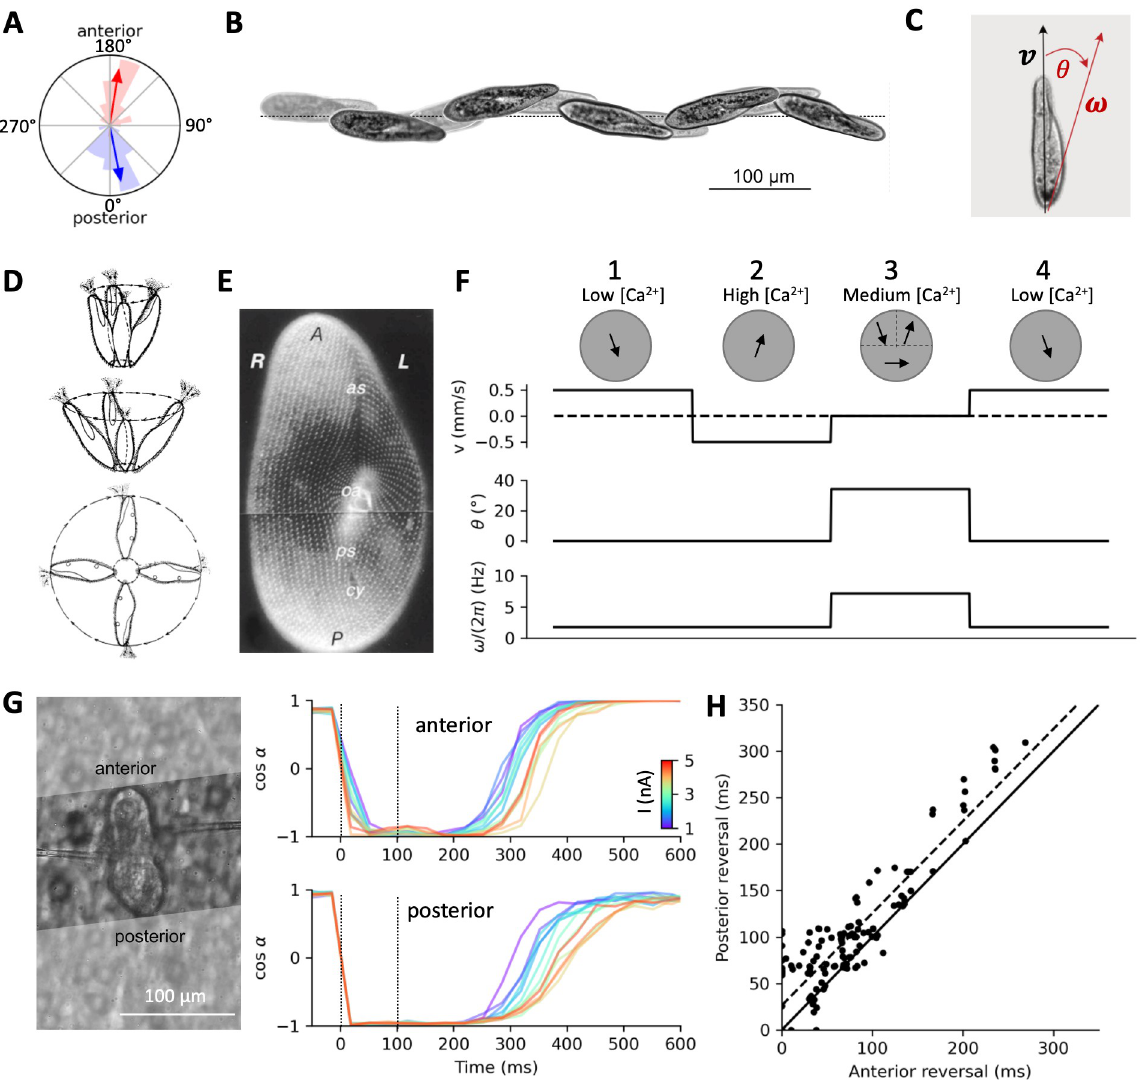
Fig 8. Swimming and turning. A, Direction of fluid motion during forward swimming (blue) and backward swimming (red), relative to the anteroposterior axis. Averages are shown by arrows. B, Example of helicoidal motion of Paramecium, with the oral groove facing the axis. Highlighted frames are spaced by 750 ms. C, The translational velocity vector v is oriented along the anteroposterior axis. The rotation vector ω is in the dorsoventral plane (including the oral groove), making an angle θ with the anteroposterior axis. D, Rotating movement of the cell at the end of avoiding reactions of increasing strength [27]. E, Organization of ciliary basal bodies on the oral (ventral) side [10]. The oral apparatus (oa) is in the center (R: right; L: left; A: anterior; P: posterior; as: anterior suture; ps: posterior suture; cy: cytoproct). F, Calculation of kinematic parameters v, θ and ω in a spherical model of radius 60 μ m, during successive phases of the avoiding reaction. First column: cilia beat to the rear and right, producing an axisymmetric force field pushing the organism forward while spinning around its axis. Local force amplitude is adjusted for a velocity of 500 μ m/s. Second column: cilia revert and now beat to the front and right, pushing the organism backward. Third column: anterior left cilia revert back to the initial direction while anterior right cilia still beat towards the front, and posterior cilia partially revert, beating to the right. Translational velocity is now 0 and the rotation axis tilts to about 34˚. Spinning speed ω also increases by a factor four. Fourth column: all cilia revert back to the initial beating direction. G, Measurement of fluid velocity in a sample cell beyond the anterior end (top) and beyond the posterior end (bottom), in response to 100 ms positive current pulses (1–5 nA), relative to the anteroposterior axis. H, Over n = 9 cells, the direction of posterior motion reverts back about 30 ms after anterior fluid motion (dashed line: linear regression; solid line: identity). Reversal duration is calculated as the time when cos( α ) crosses 0, relative to the pulse end time.